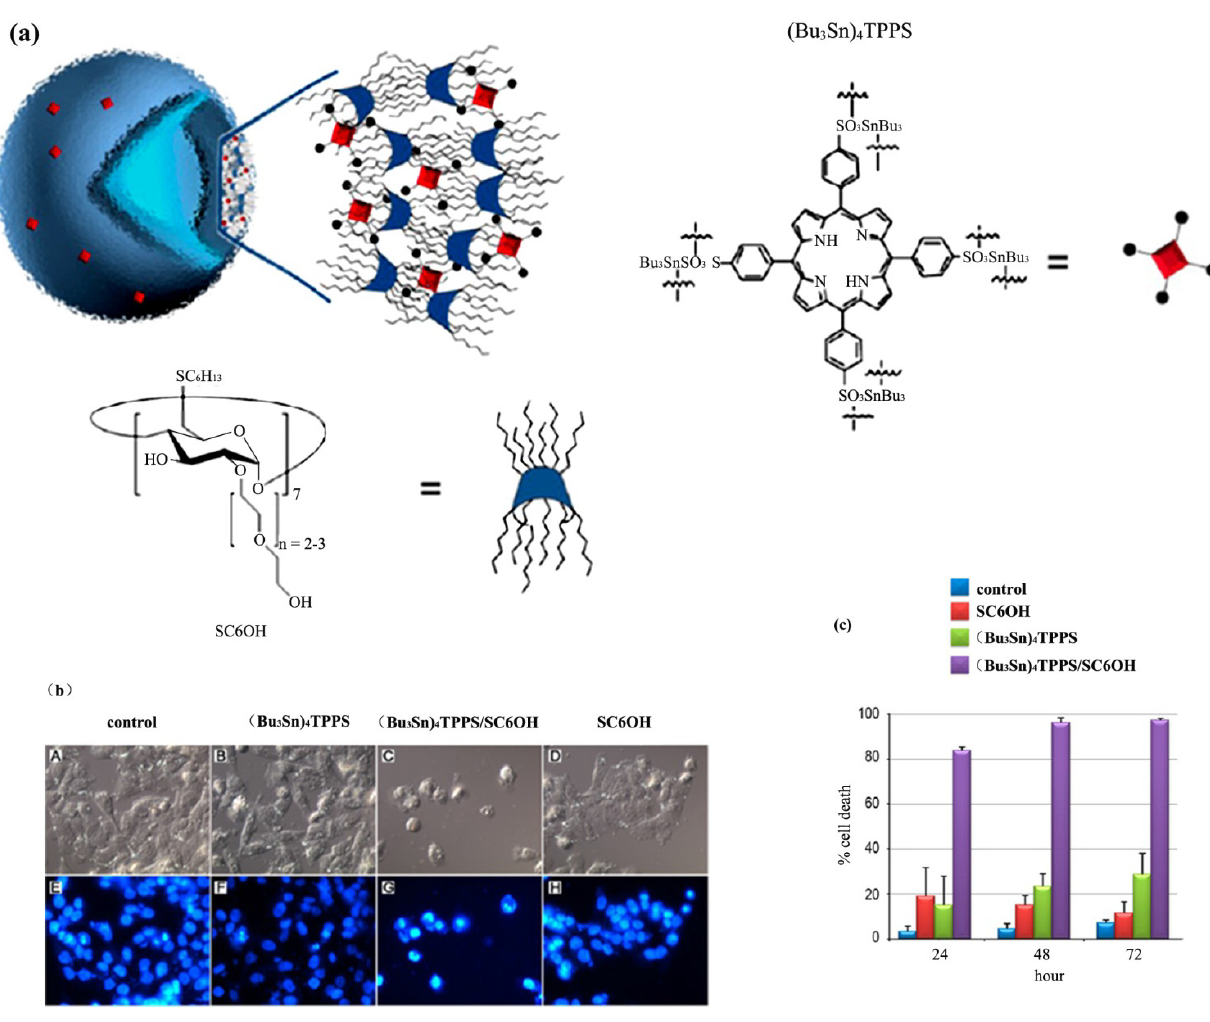
Figure 3. Supramolecular assemblies of amphiphilic cyclodextrins studied in vitro as potential nanotherapeutics [30]. ( a ) Chemical composition of the nanoassemblies of SC6OH (heptakis(2- O -oligo(ethylene oxide)-6-hexylthio)-β-CD) and (Bu ( meso -tetra(4-sulfonatophenyl)porphine tributyltin(IV) derivative) formed in aqueous medium; ( b ) nuclear morphology of A375 melanoma cells treated with (Bu Sn) TPPS/SC6OH nanoassemblies; ( c ) cytotoxic effects of (Bu 3 4 nanoassemblies on the A375 human melanoma cells viability. Reprinted with permission from [30]. Copyright 2013, American Chemical